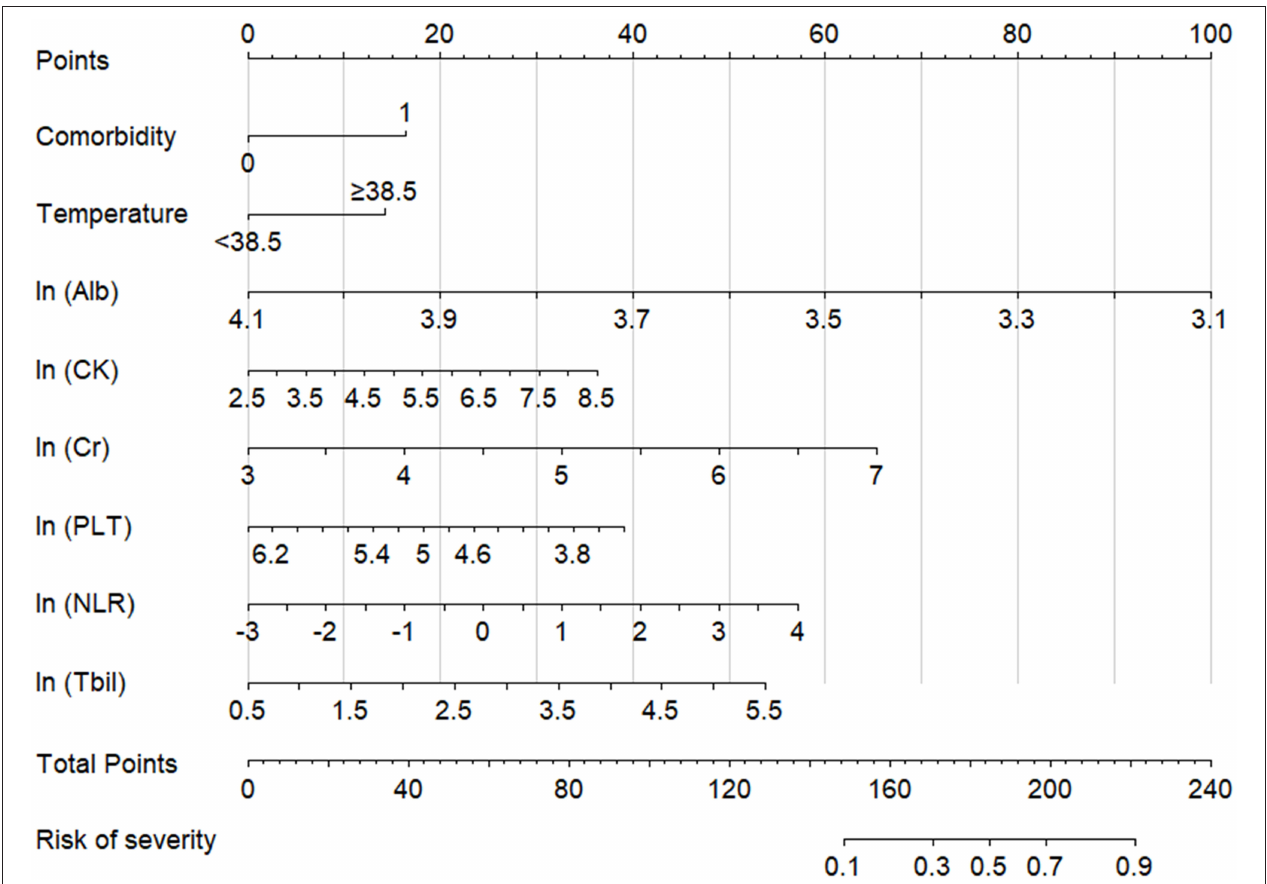
FIGURE 2 | Nomogram model for assessing the risk of severe COVID-19. Total points are calculated by adding each point of the factors, such as comorbidities, temperature, ln (Alb), ln (CK), ln (Cr), ln (PLT), ln (NLR), and ln (Tbil), and the severity risk stratum of a patient can be obtained by projecting the total points downward. The higher that the score is, the higher that the probability of severe disease is. Regarding comorbidities, “0” indicates absent, and “1” indicates present. NLR, neutrophil-to-lymphocyte ratio; PLT, platelet; Alb, albumin; Tbil, total bilirubin; Cr, creatinine; CK, creatine